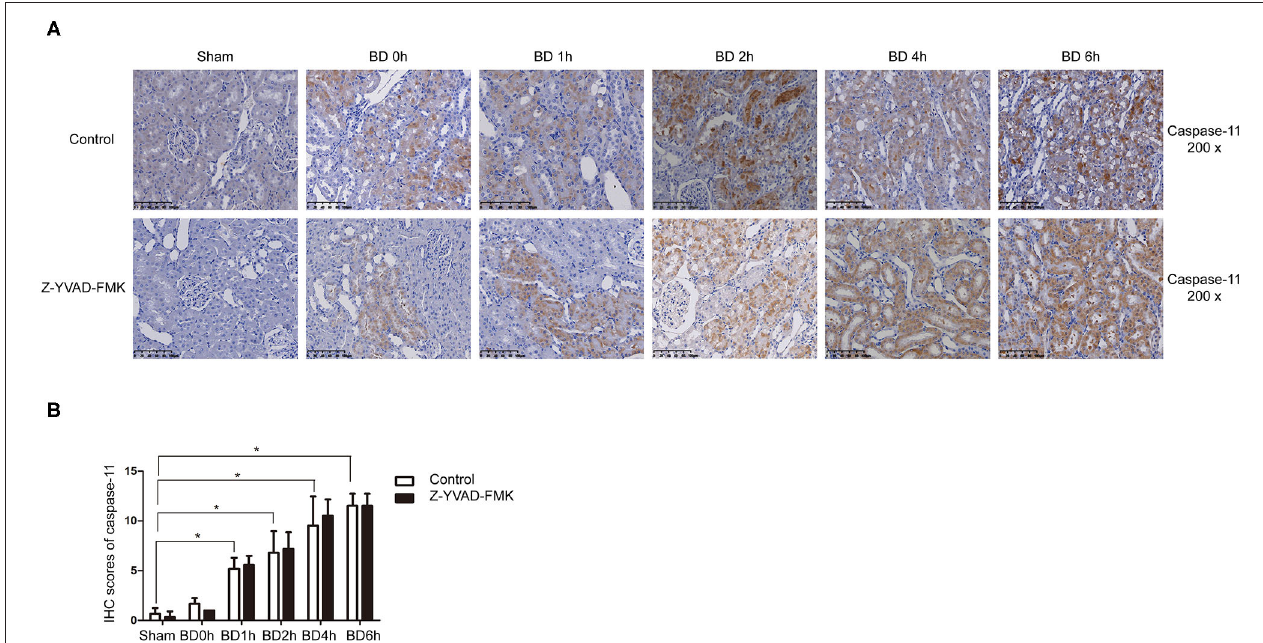
FIGURE 3 | Immunohistochemical (IHC) score of caspase-11 in control cohort and Z-YVAD-FMK-treated cohort. There were sham, BD 0, 1, 2, 4, and 6h group ( n = 6 in each group) in each cohort. (Magnification 200 × ). (A) Control cohort and Z-YVAD-FMK-treated cohort. (B) IHC score of caspase-11 in different groups. * p < 0.05. BD = brain-death; Sham = without brain